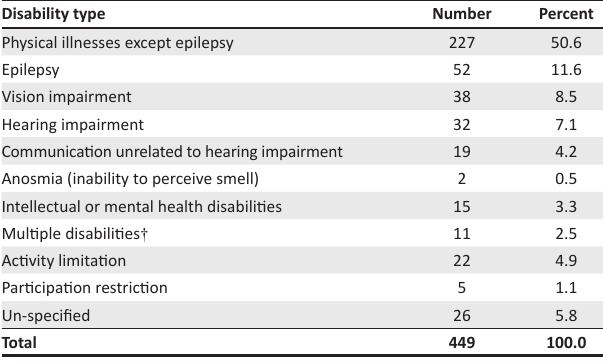
TABLE 2: Types of